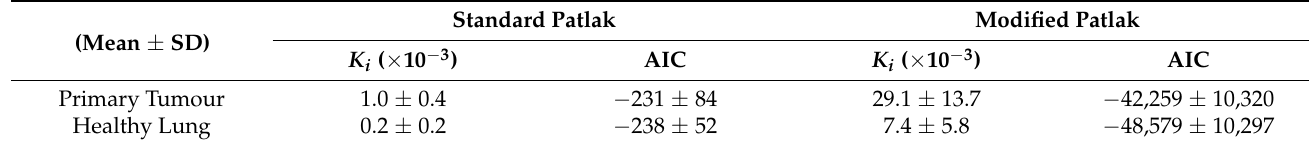
Table 1. The results of the standard and modified Patlak plots.